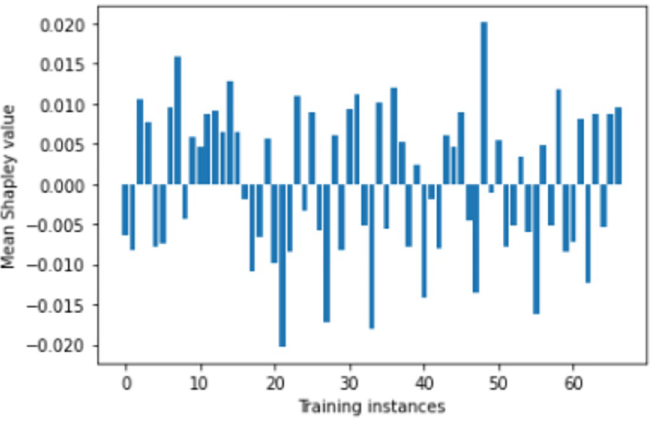
Fig 7. Estimation of input attribution for “ItalyPowerDemand”